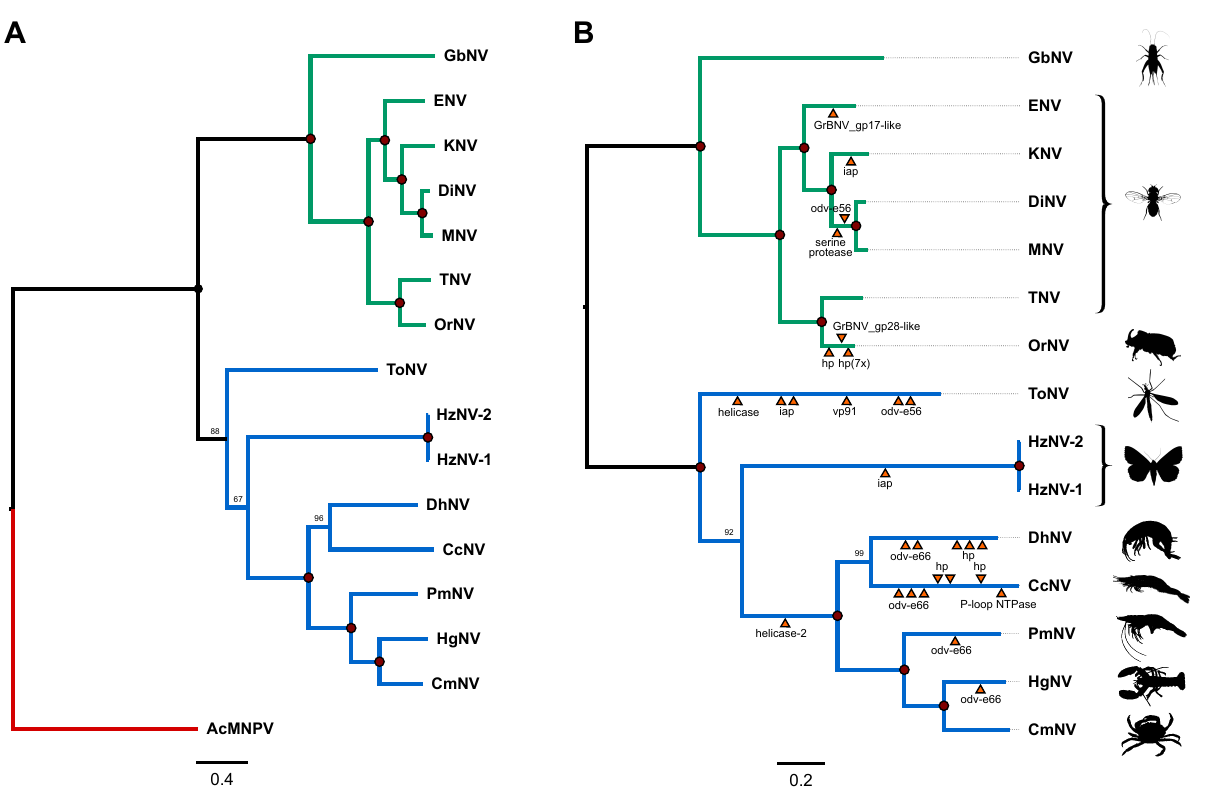
Figure 3. Phylogenetic trees based on concatenated nudivirus protein sequences. ( A )—Maximum likelihood phylogeny based on a supermatrix of 19 concatenated pruned orthologous protein sequences (6961 amino acids; 38K protein, Ac81-like protein, DNA polymerase, FEN-1, GbNV_gp67-like, integrase, LEF-4, LEF-8, LEF-9, P33, PIF-0, PIF-1, PIF-2, PIF-3, PIF-4, PIF- 6, TK3, VLF-1 and VP91) derived from 15 nudiviruses and Autographa californica multiple nucleopolyhedrovirus (AcMNPV; NC_001623.1), which was used as the outgroup. ( B ). Maximum likelihood phylogeny based on 27 concatenated nudivirus core genes (5244 amino acids in total) of 15 nudiviruses. Gene duplication events identified by OrthoFinder are indicated by orange triangles. hp = hypothetical protein. Node labels indicate bootstrap support expressed as a percentage and solid red dots indicate 100% support. CcNV = Crangon crangon nudivirus (MZ311577), CmNV = Carcinus maenas nudivirus (MZ311578), DhNV = Dikerogammarus haemobaphes nudivirus (MT488302.1), DiNV = Drosophila innubila nudivirus (NC_040699.1), ENV = Esparto virus (NC_040536.1), GbNV = Gryllus bimaculatus nudivirus (NC_009240.1), HgNV = Homarus gammarus nudivirus (MK439999.1), HzNV-1 = Heliothis nudivirus 1 (AF451898.1), HzNV-2 = Heliothis nudivirus 2 (NC_004156.2), KNV = Kallithea virus (NC_033829.1), MNV = Mauternbach virus (MG969167), OrNV = Oryctes rhinoceros nudivirus (NC_011588.1), PmNV = Penaeus monodon nudivirus (KJ184318), TNV = Tomelloso virus (NC_040789.1), ToNV = Tipula oleracea nudivirus